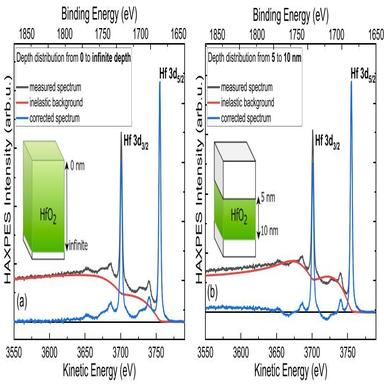
QUASES-Analyze IBA of Hf 3d in bulk HfO2 recorded with Cr Kα source. The black line is the raw measured data, and the red line is the inelastic background calculated by the software. The blue line is the spectrum which has been corrected for inelastic losses by subtracting the red line. A good fit between measured and calculated inelastic backgrounds is seen in (a) where the depth distribution of an infinite medium is accurate. A poor fit is seen in (b) where the depth distribution of 5–10 nm is incorrect.